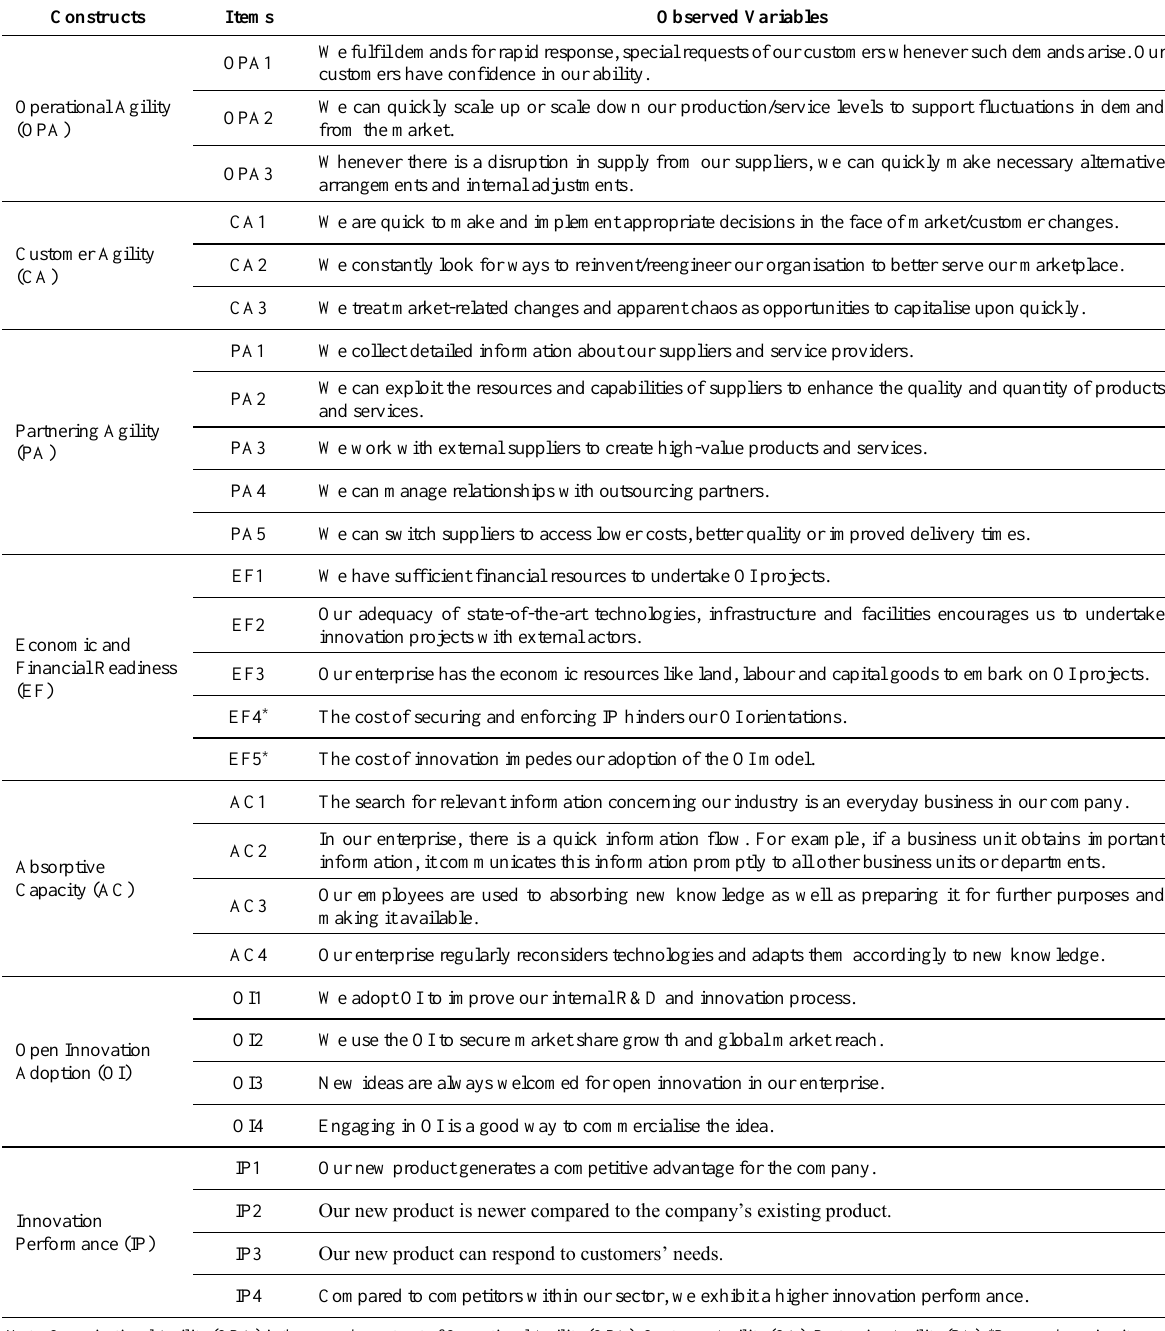
Table 1. Questionnaire constructs and